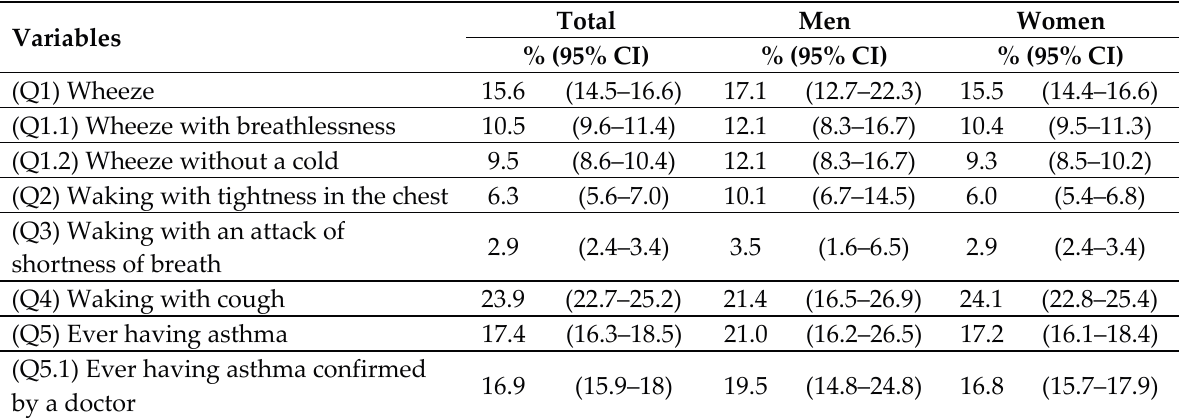
Table 2. Prevalence of asthma-related symptoms.